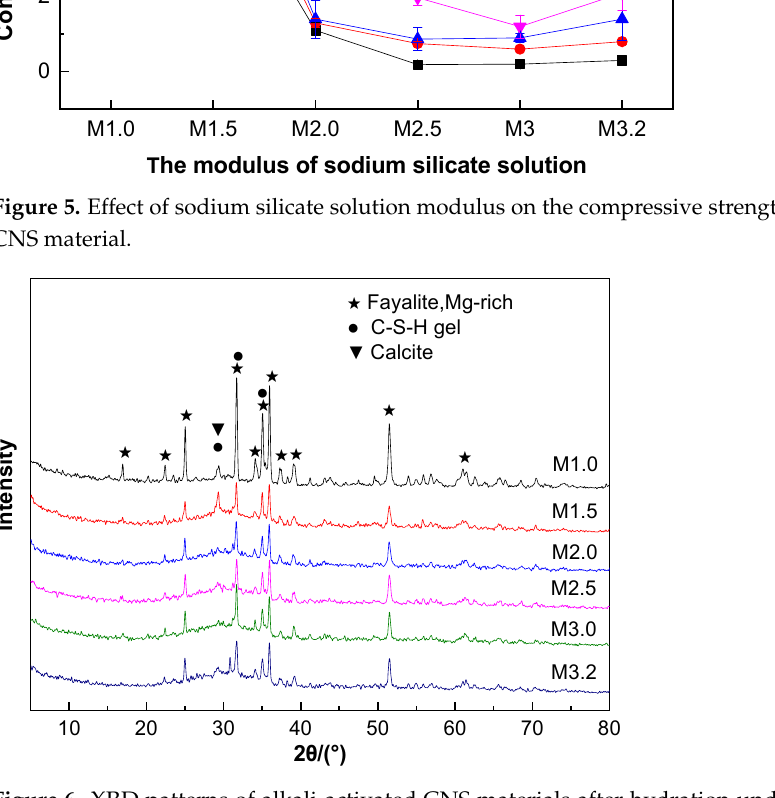
Figure 6. XRD patterns of alkali-activated CNS materials after hydration under different sodium silicate solution moduli.